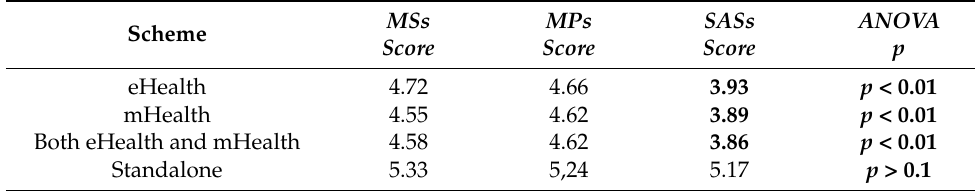
Table 5. Specific outcome of the opinion on the use/delivery of the